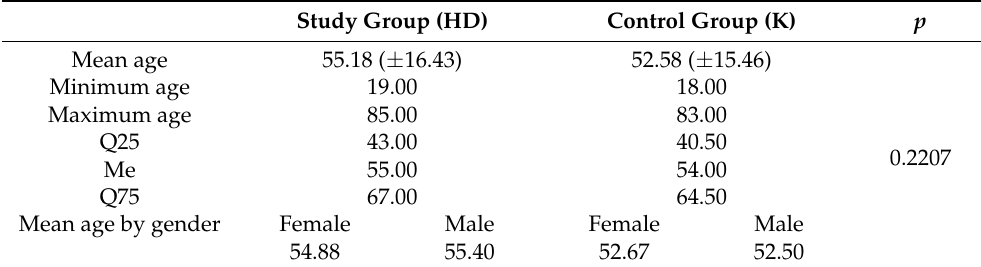
Table 1. Summary of mean and extreme values of age in both study